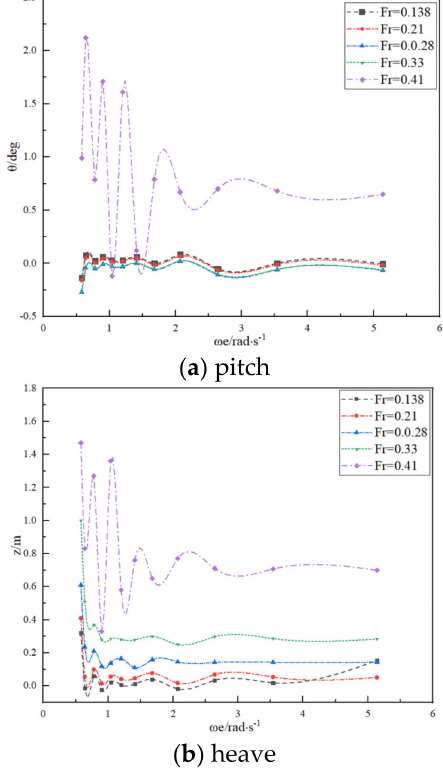
Figure 12. Calculation results under